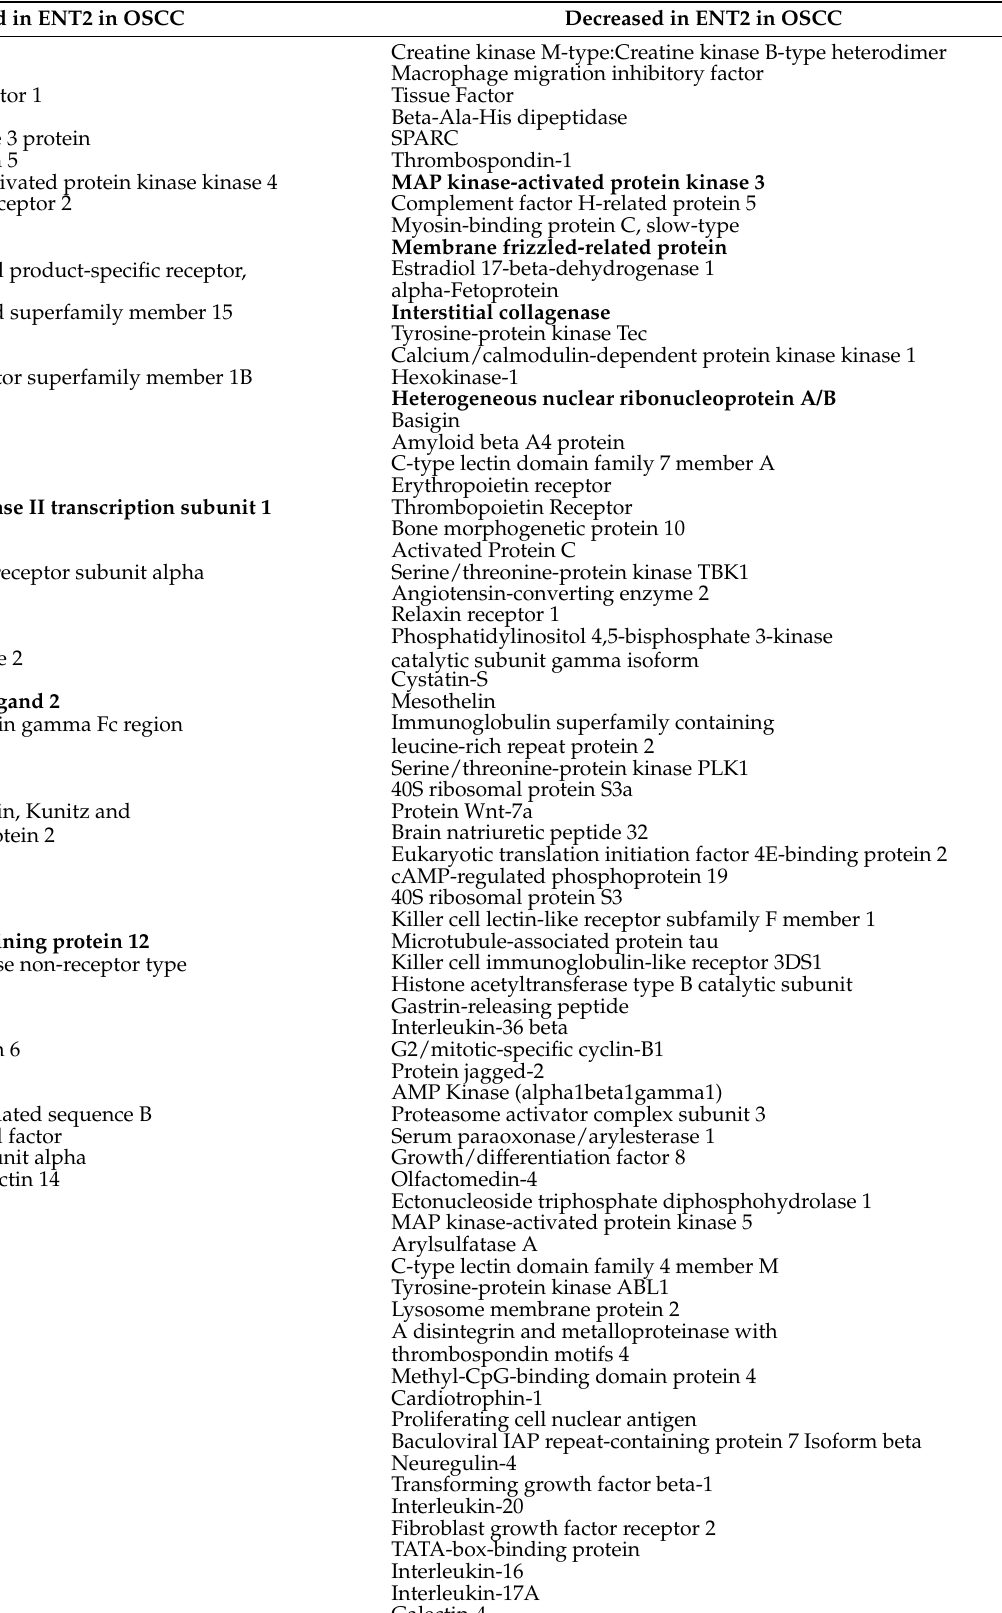
Table 3. Top Up-Regulated and Down-Regulated Proteins Between ENT2 and ENT1 in OSCC